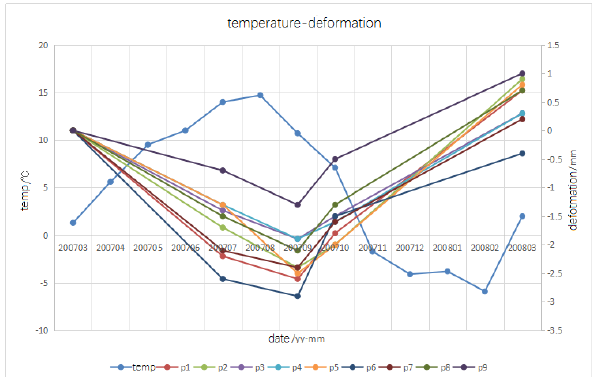
Figure 6. Temperature-Deformation Change